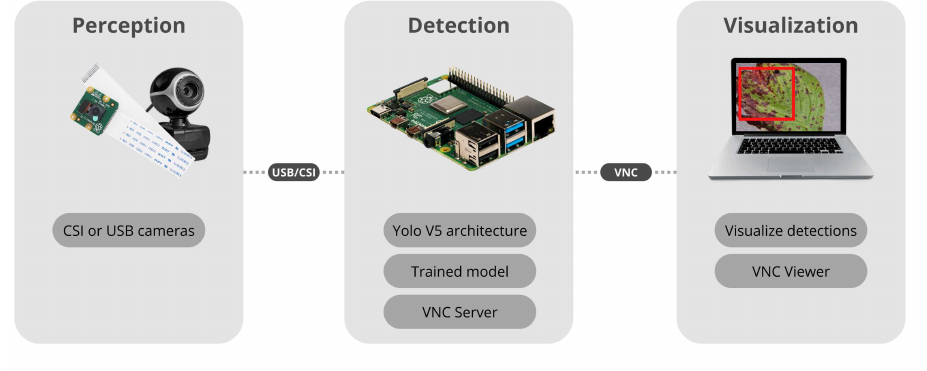
Figure 3. Computer vision system